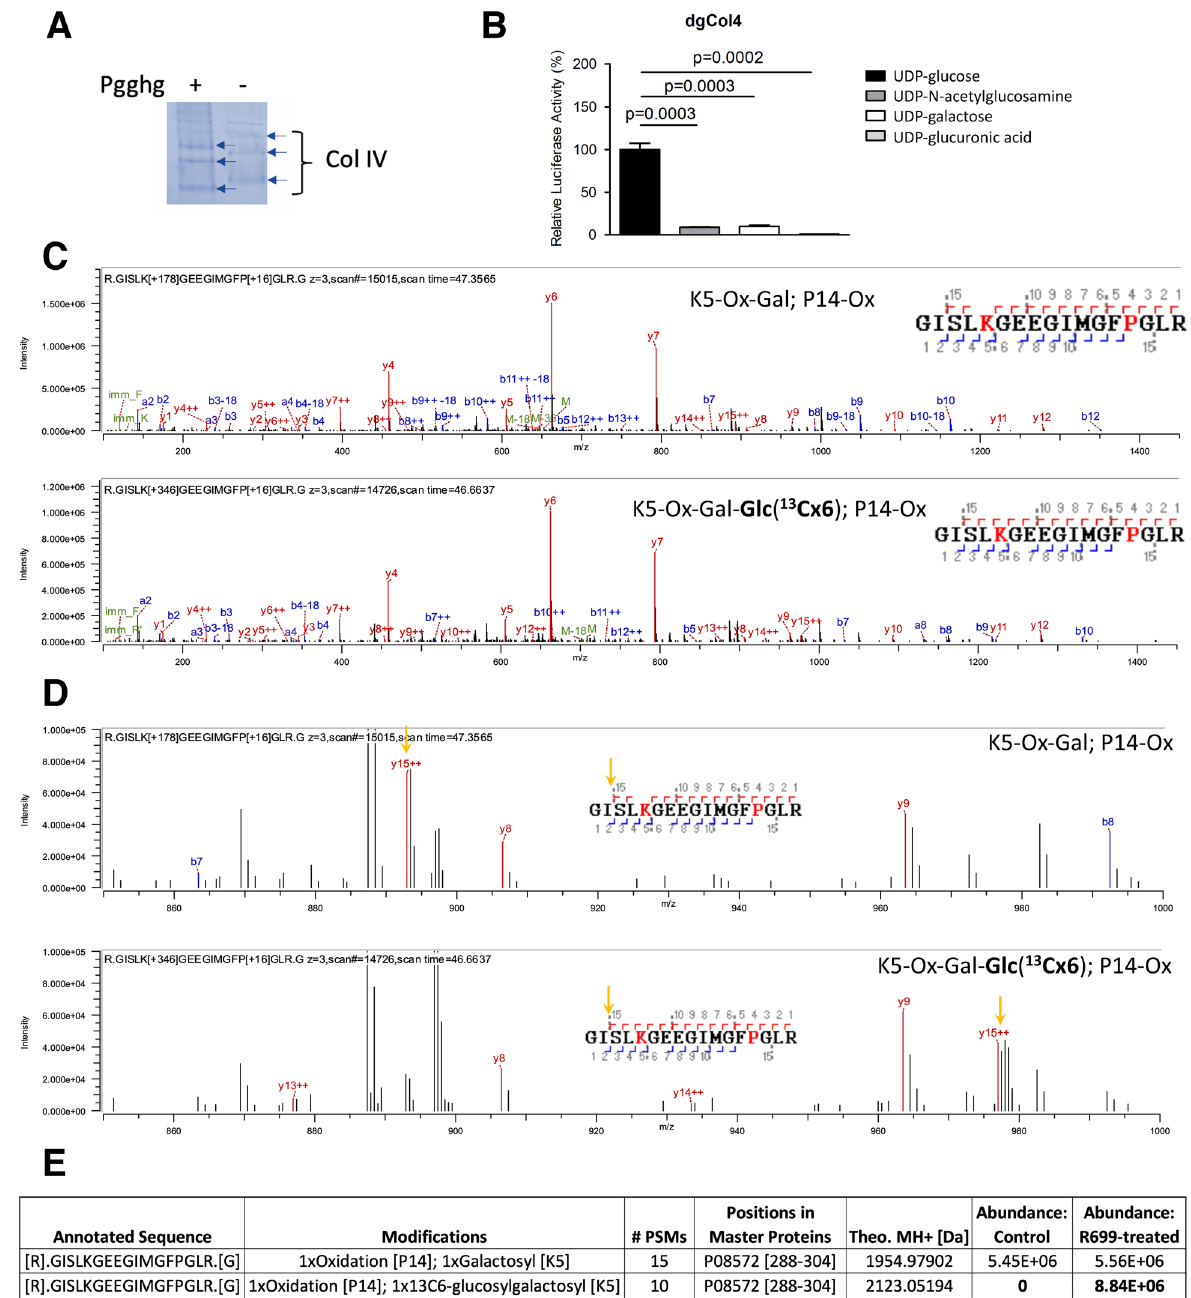
Figure 4. R699 is a collagen GGT. ( A ) Type IV collagen that had been pre-treated with wild-type (+) protein-glucosylgalactosylhydroxylysine glucosidase (PGGHG) or sham-treated (-) was analyzed using SDS– polyacrylamide gel electrophoresis. Gel image was recolored. ( B ) R699 collagen GGT activity was assayed. Substrate was deglucosylated type IV collagen from A and GGT activity was measured similarly as in Fig. 3B. Mean ± SD of 3 replicates, p values, two-tailed Student’s t test. ( C ) MS/MS analysis of type IV collagen. R699 GGT assay was performed using deglucosylated type IV collagen and UDP-[UL- 13 C 6 ] glucose. Peptides containing galactosyl-hydroxylysine (Gal-Hyl, top) or Carbon-13 labeled glucosyl-galactosylhydroxylysine ([ 13 C]GlcGal-Hyl, bottom) were detected by MS/MS. The spectra exhibit peaks corresponding to b and y ion series from fragmentation of each peptide. Peptide sequences with the identified fragment ions were indicated in the upper right. The b and y ions were labeled in the spectra and indicated on the peptide sequence in upper right. ( D ) Zoom-in of spectra in ( C ) showing y15++. Peptide sequences, b and y ions were labeled similarly as in ( C ). The locations of y15++ in the spectra and peptide sequences were highlighted with yellow arrows. ( E ) The details about peptide sequences, modifications, and abundance were